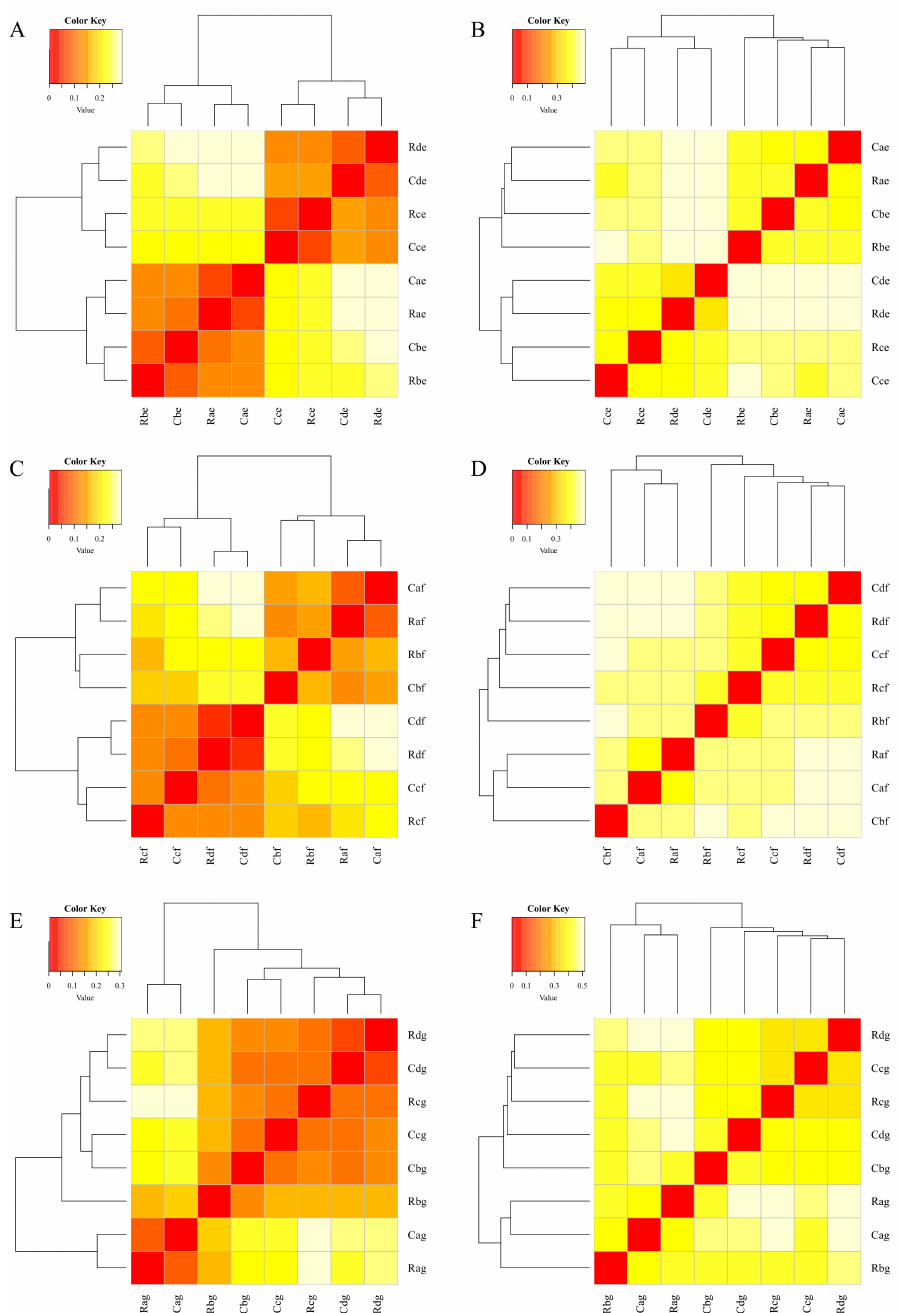
Figure 7. Soil layer abundance thermograms. ( A , C , E ) Weighted_unifrac; ( B , D , F ) unweighted_unifrac. ( A , B ) 0–10 cm; ( C , D ) 10–20 cm; ( E , F ) 20–30 cm. Each value represents mean ± SD ( n = 3). R, C indicate atrazine and control group, respectively, with recommended dose; a, b, c, d indicate soil samples at 1, 7, 21, and 119 d after spraying, respectively; e, f, g indicate soil samples at 0–10, 10–20, and 20–30 cm soil level,